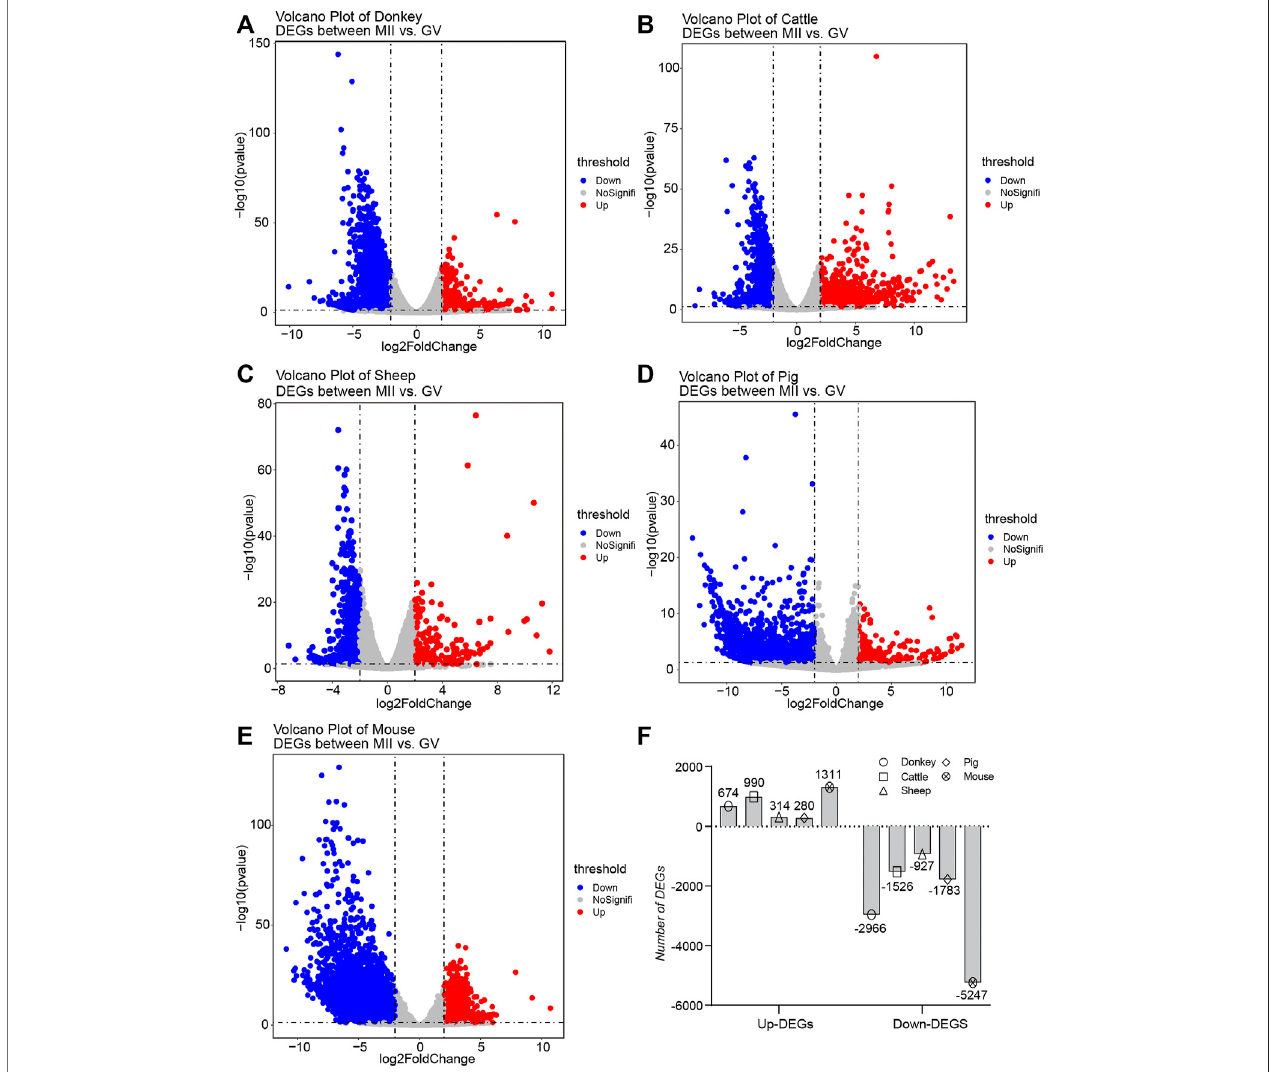
FIGURE 2 | Overview of the differentially expressed genes (DEGs) during oocyte development in different species (A – E) The volcano plot exhibits the differential expression levels of oocytes during the period from germinal vesicle (GV) to metaphase II (MII) in different species, including donkey, cattle, sheep, pig, and mouse. (F) The bar plot shows the number of DEGs during the period from GV to MII in different species.